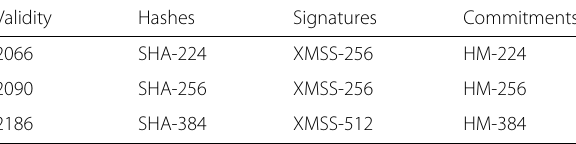
Table 2 Parameter selection based on Lenstra and